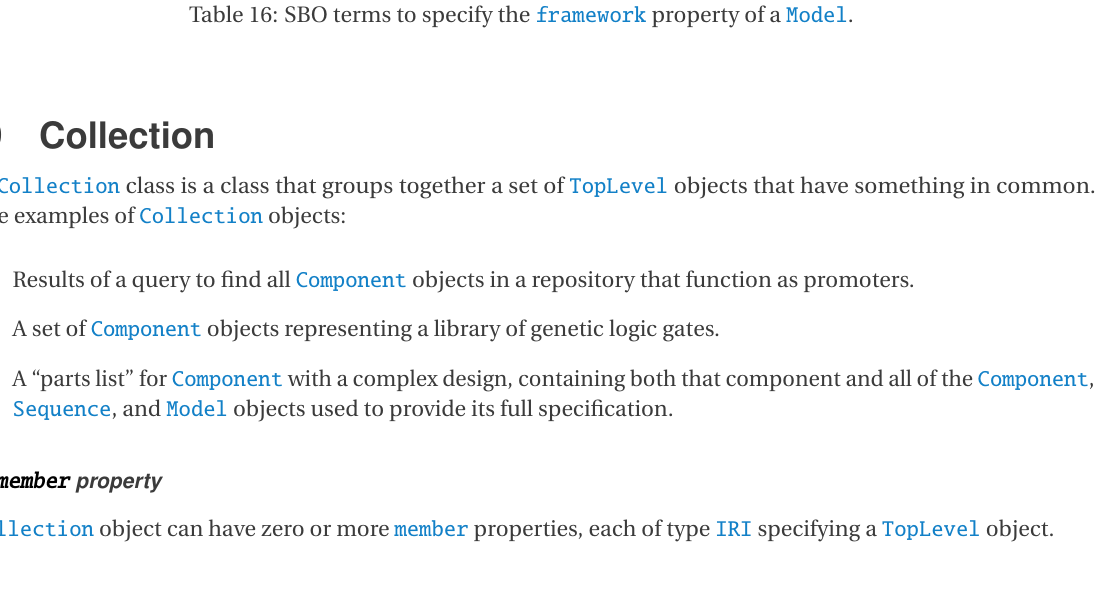
Table 16: SBO terms to specify the framework property of a Model